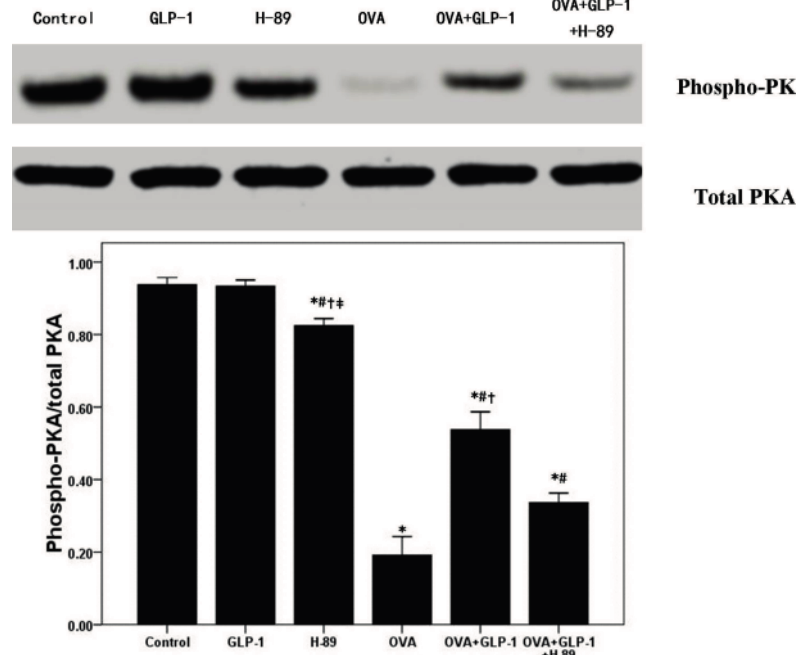
Figure 5. GLP-1 promotes the phosphorylation of PKA in lung in OVA-induced chronic asthma. Western blotting was performed to evaluate the phosphorylation of PKA in the lung tissues. Each bar represents the mean ± SD of 10 mice. * p < 0.05 compared with Control. # p <0.05 compared with OVA. † p < 0.05 compared with OVA + GLP-1 +